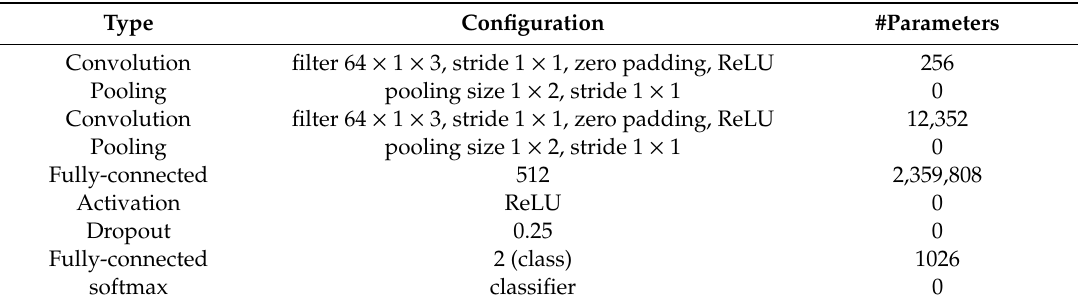
Table 4. The proposed deep convolutional neural network (CNN)